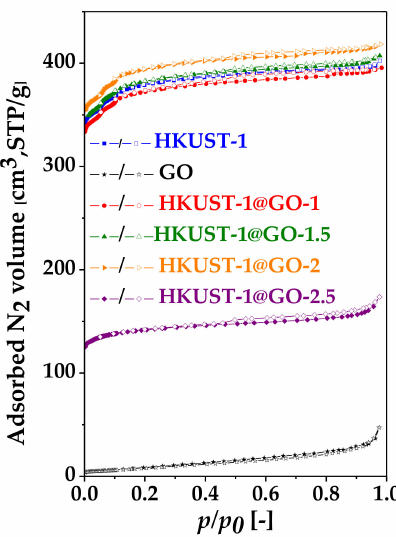
Figure 4. N 2 adsorption–desorption isotherms ( − 196 ◦ C) of the pristine GO, HKUST-1 and the composite materials with di ff erent GO contents. The adsorption and desorption branches are denoted by full and empty symbols,